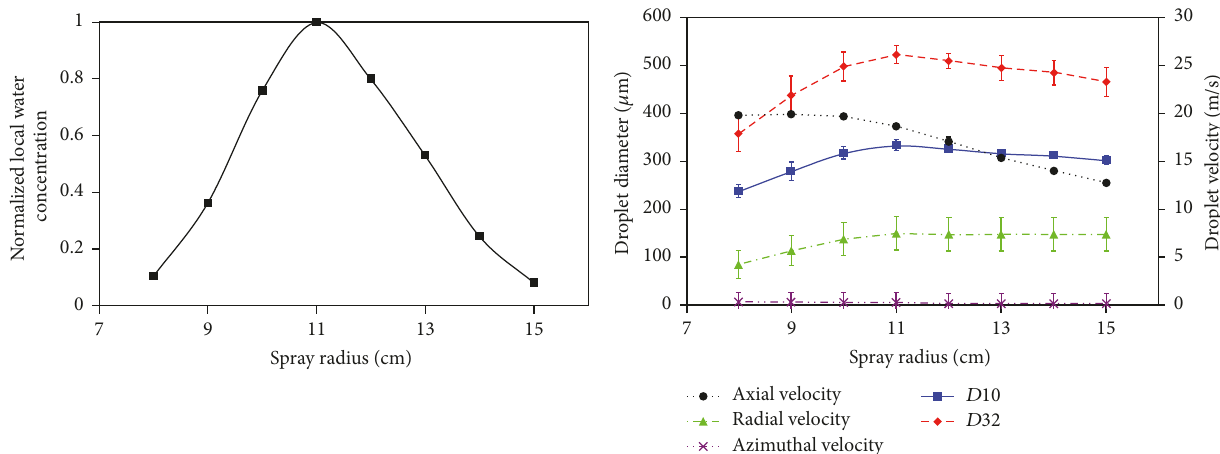
Figure 31: Mean characteristics of the spray at 20cm from the nozzle outlet (error bars are given for an 67% interval of confidence).